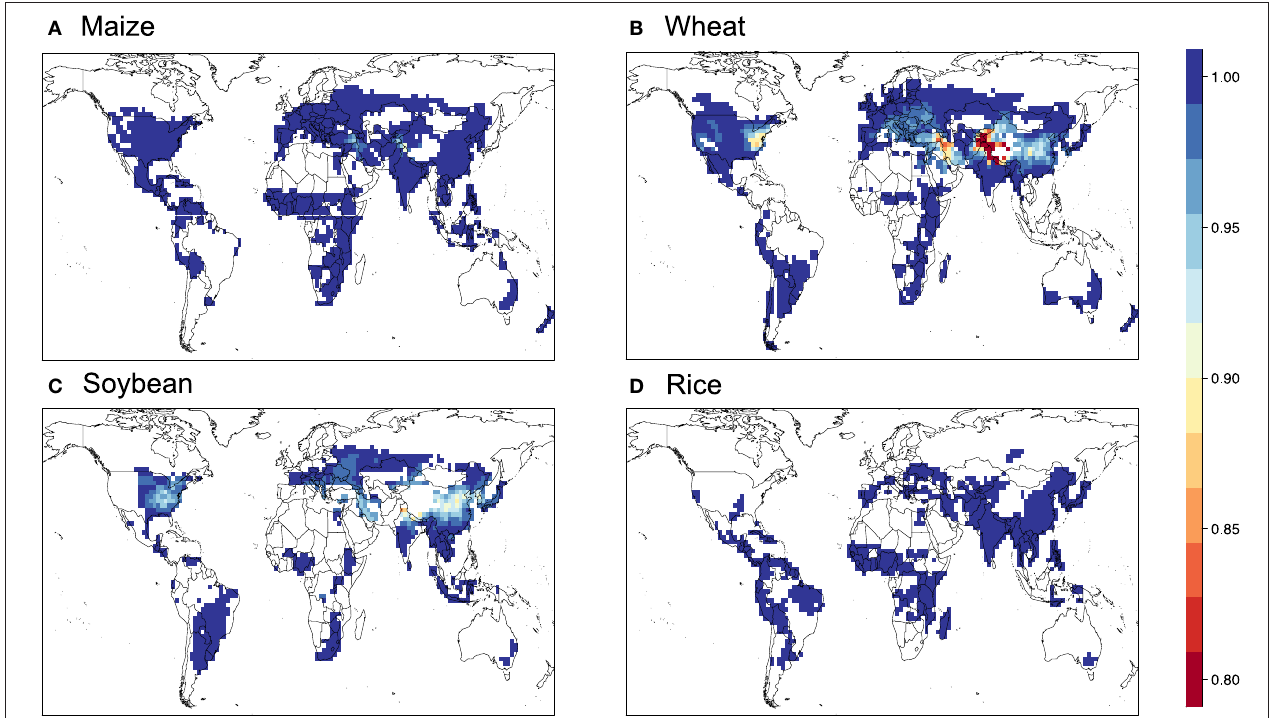
FIGURE 7 | Relative yield based on the W126 metric for (A) maize, (B) wheat, (C) soybean, and (D) rice.